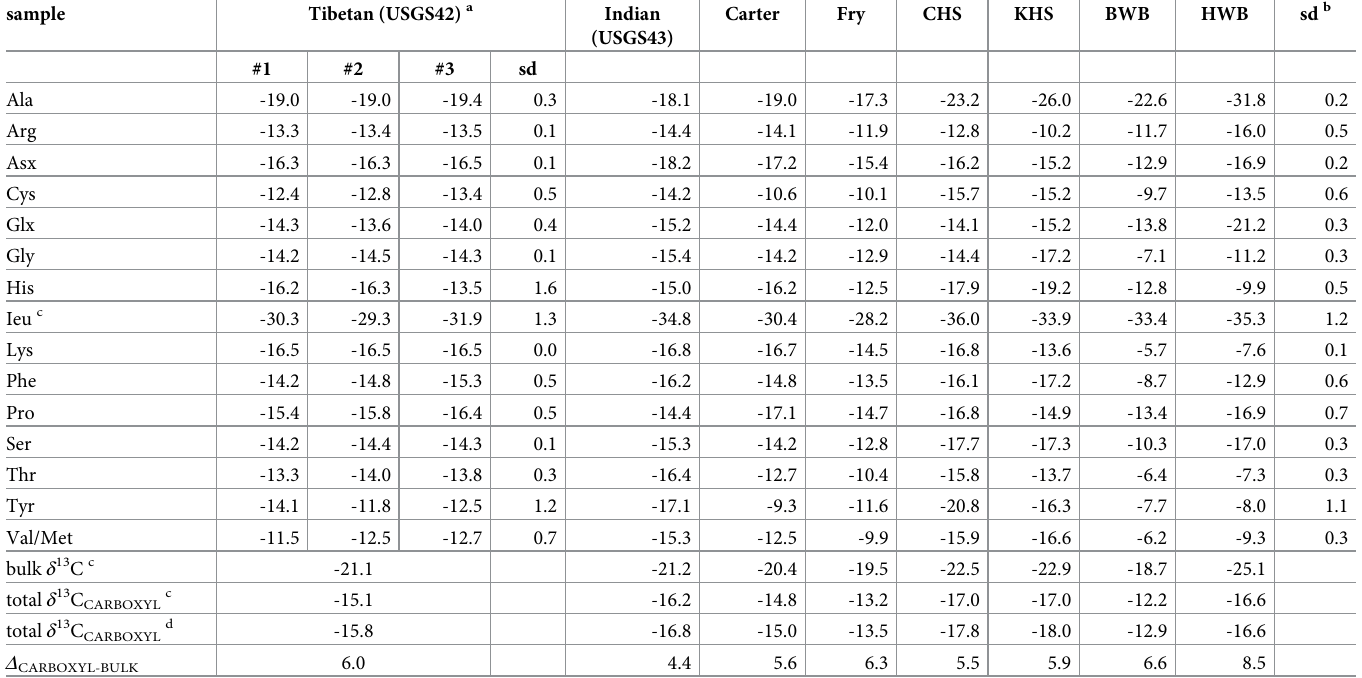
Table 5. δ 13 C CARBOXYL data for amino acids derived from keratin hydrolysates. sample Tibetan (USGS42)